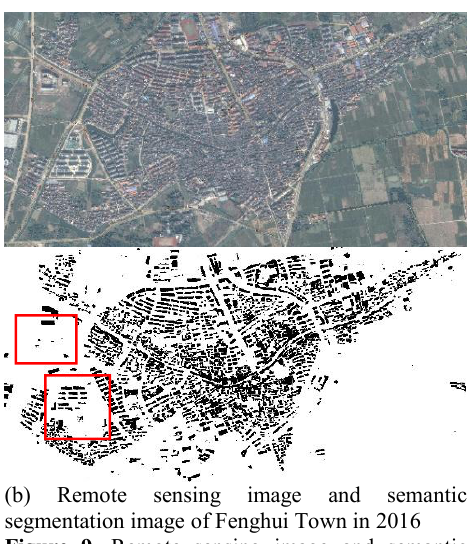
Figure 9 . Remote sensing image and semantic segmentation image of Fenghui Town in different